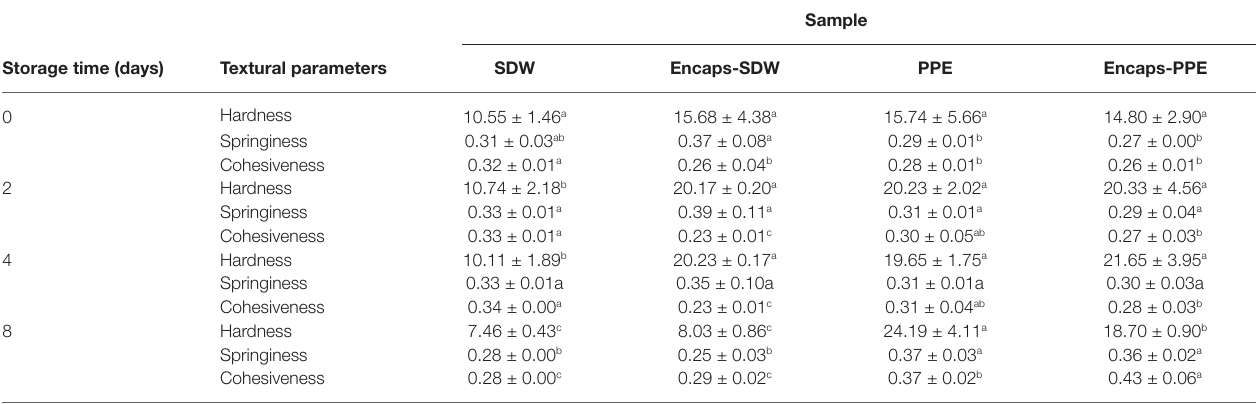
TABLE 3 | Textural properties of beef burger patties incorporating prickly pear extract (PPE) or sterile distilled water (SDW).